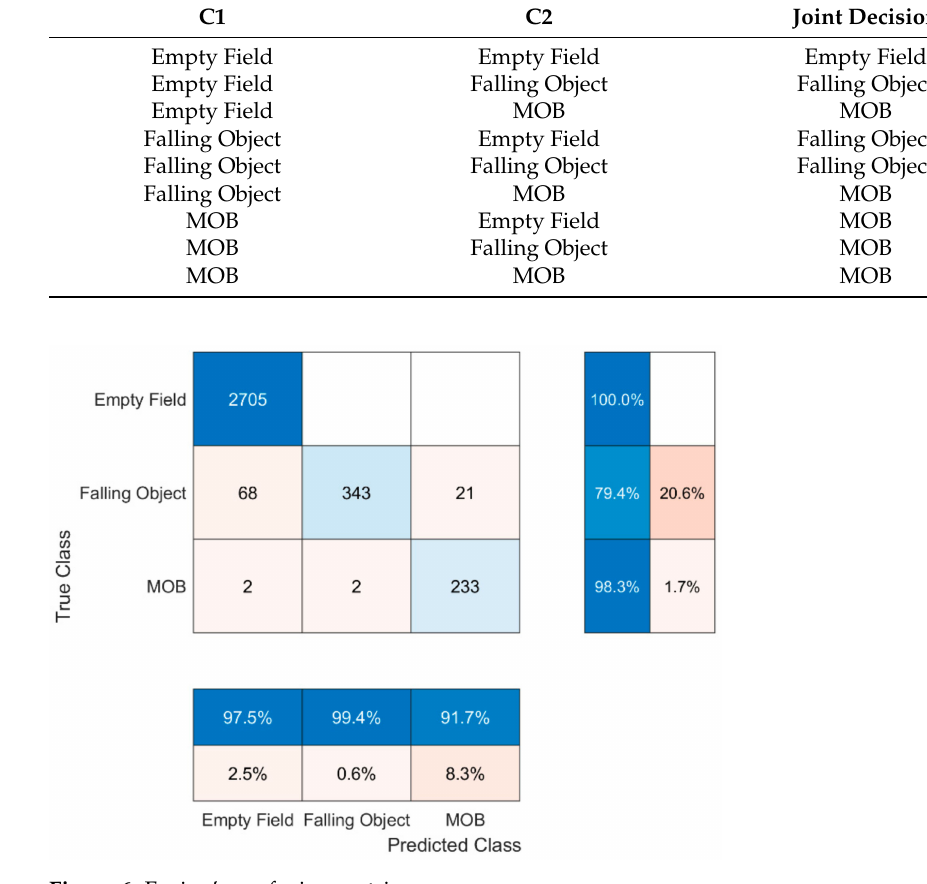
Figure 6. Fusion’s confusion matrix.